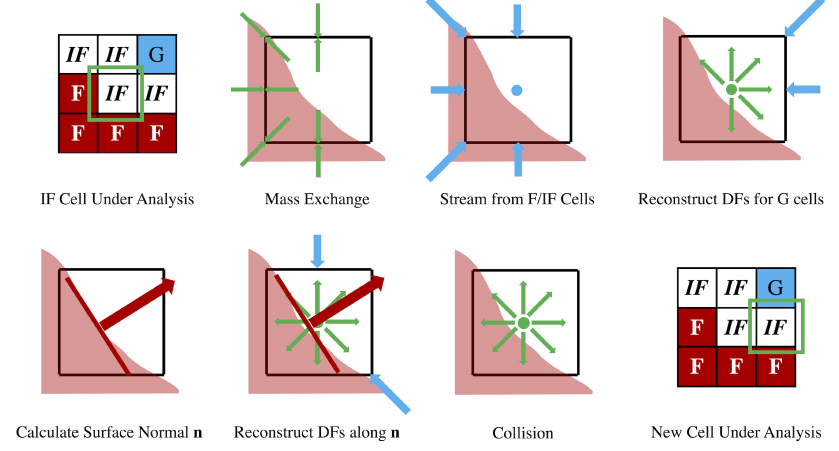
Figure 4. Schematic of the free-surface update cell procedure.